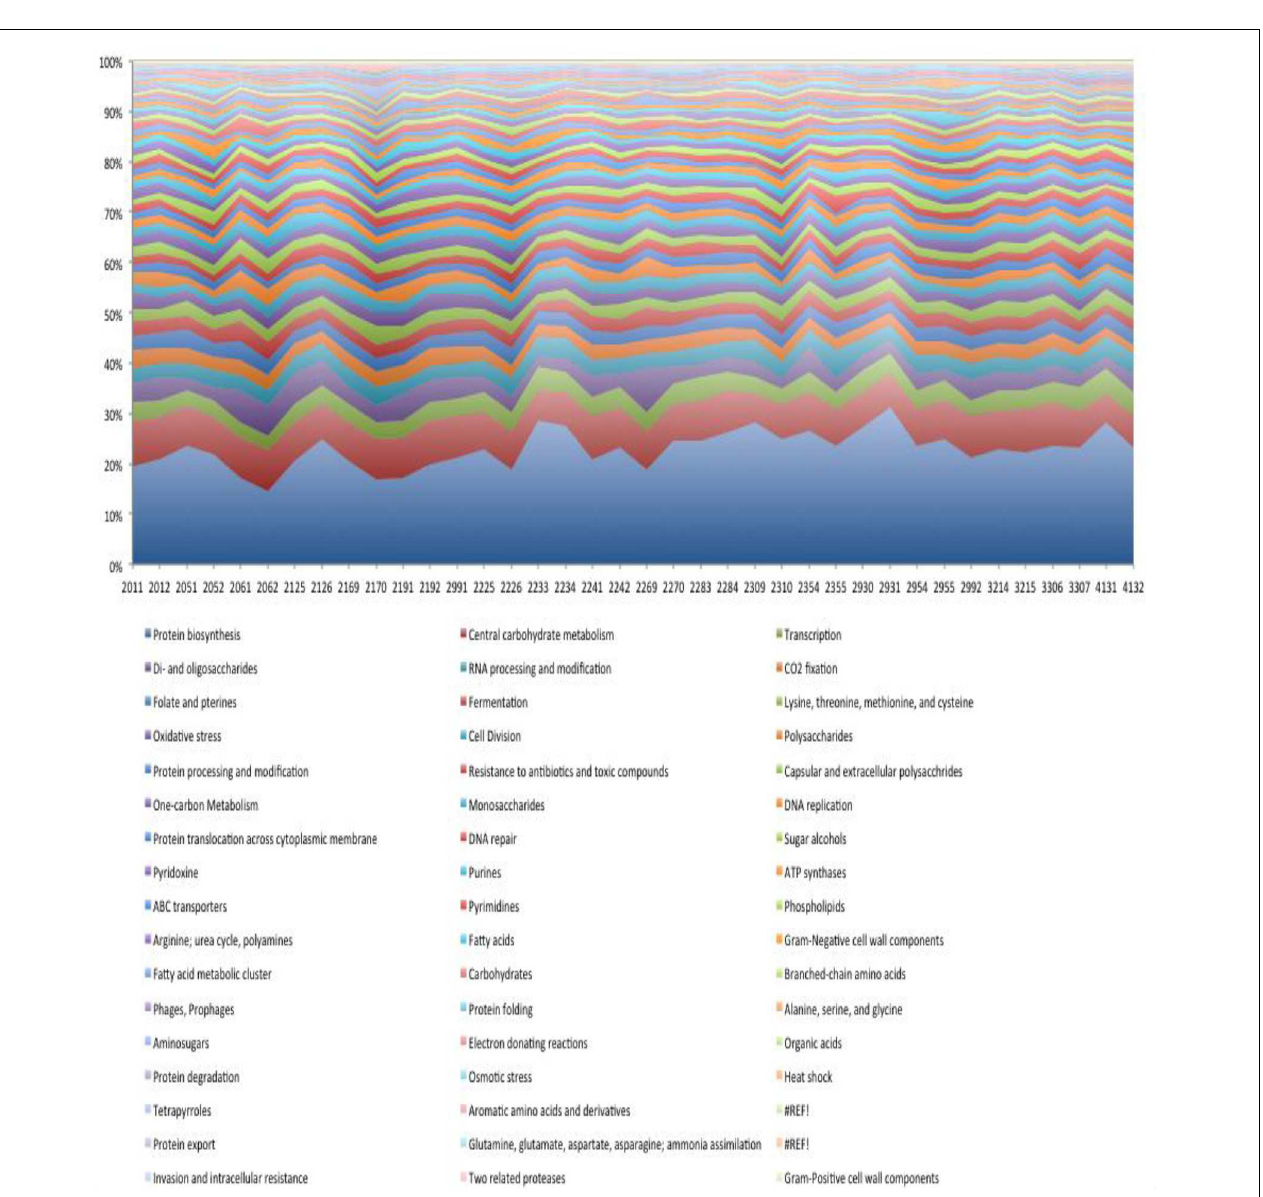
FIGURE 8 | Functional role categories expressed in dental plaque